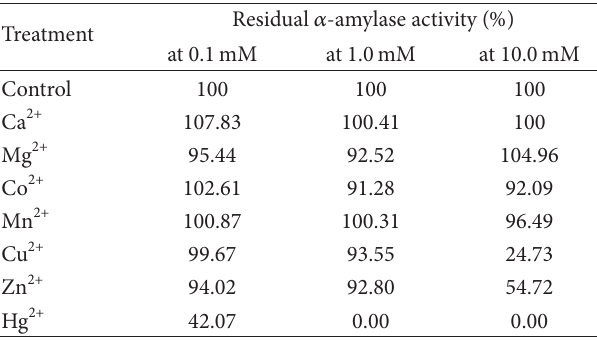
T 7: Effect of different divalent metal ions on the puri�ed amylase enzyme activity produced by Bacillus licheniformis